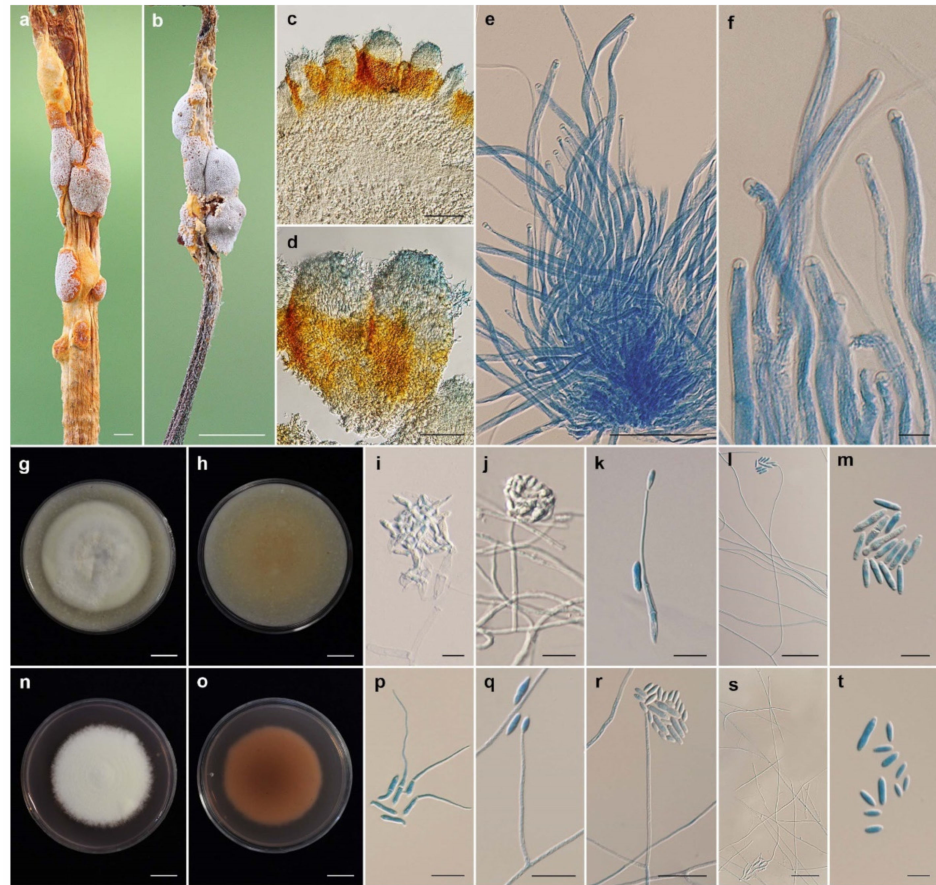
Figure 4. Ascopolyporus griseoperitheciatus . ( a , b ) Stromata on living stem of dicotyledonous